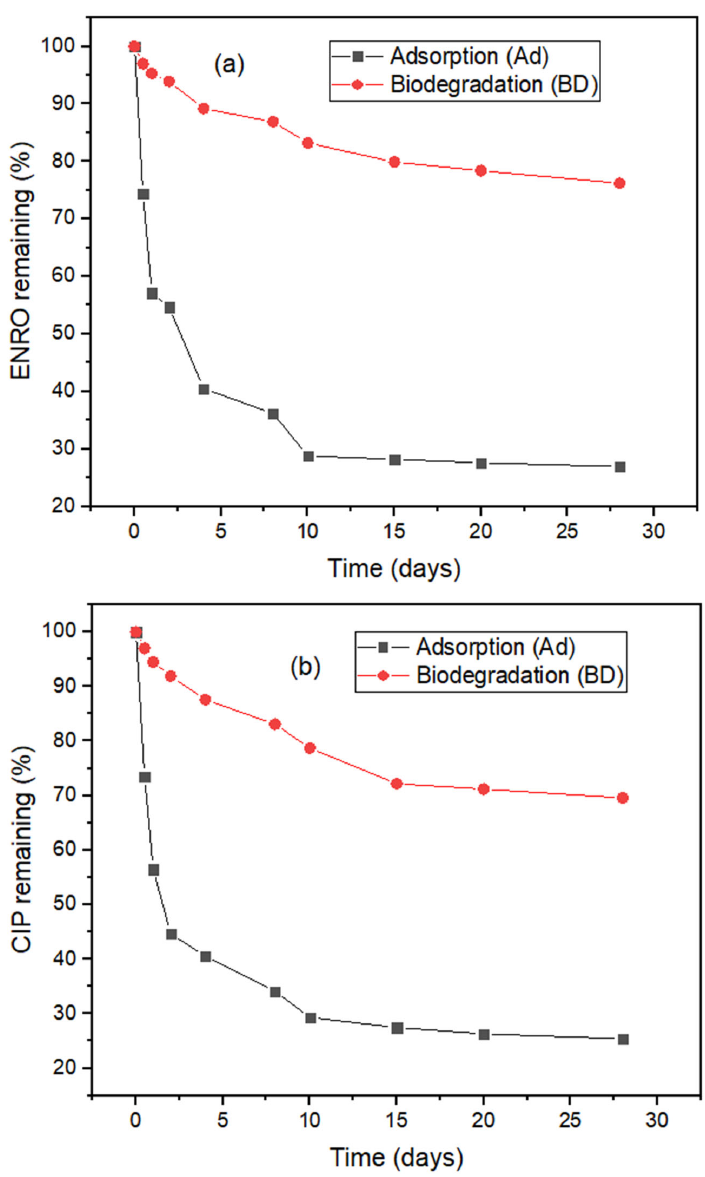
Figure 3. Biodegradation (BD) and Adsorption (AD) of ( a ) %ENRO and ( b ) %CIP removal at 35 ◦ C, pH 7, and OLR at 3.5 kg.CODm − 3 .days − 1 .